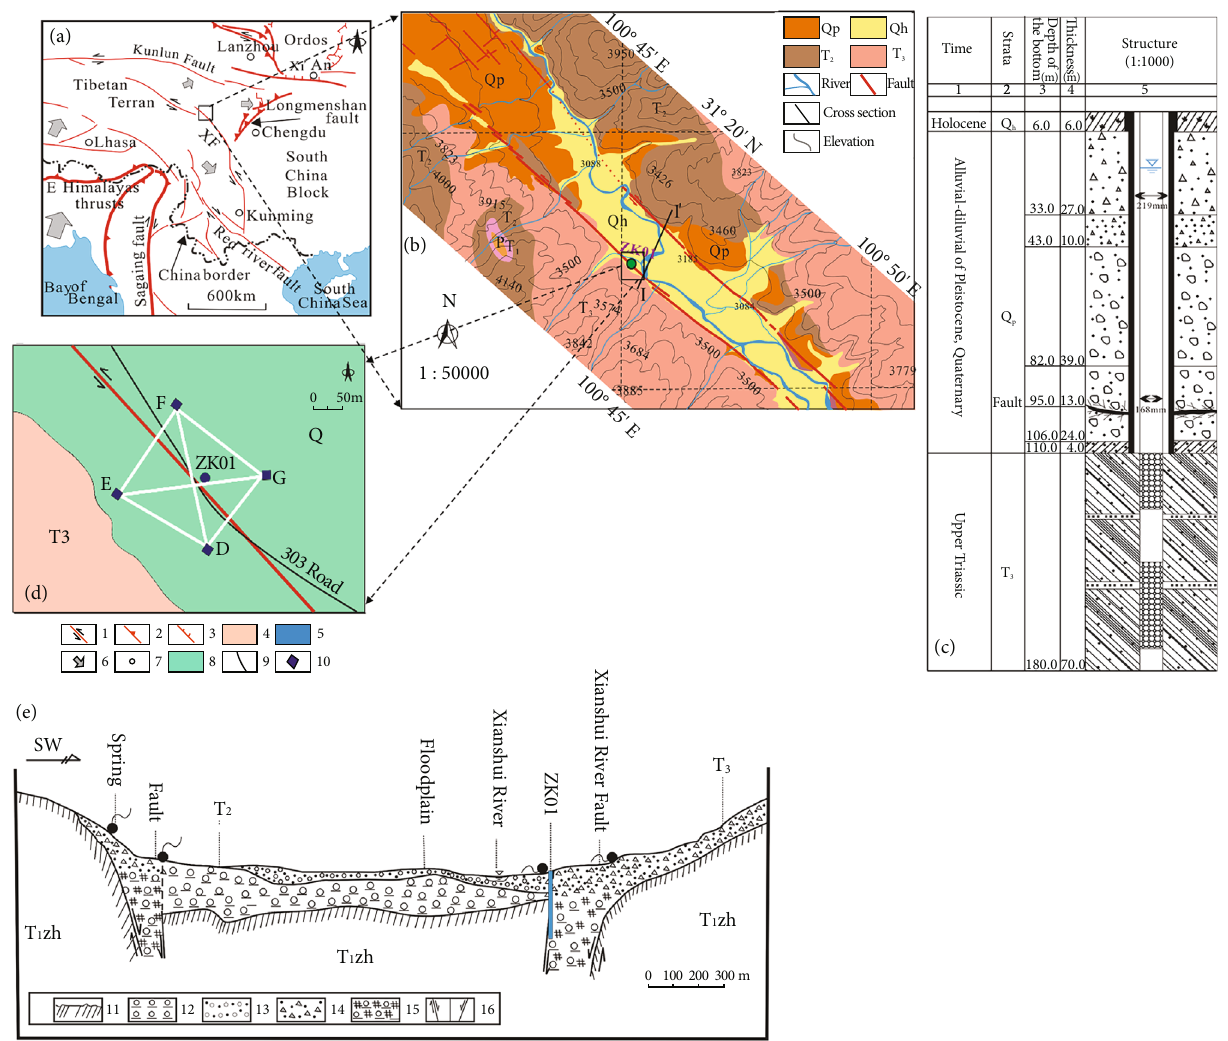
Q h and p represent the